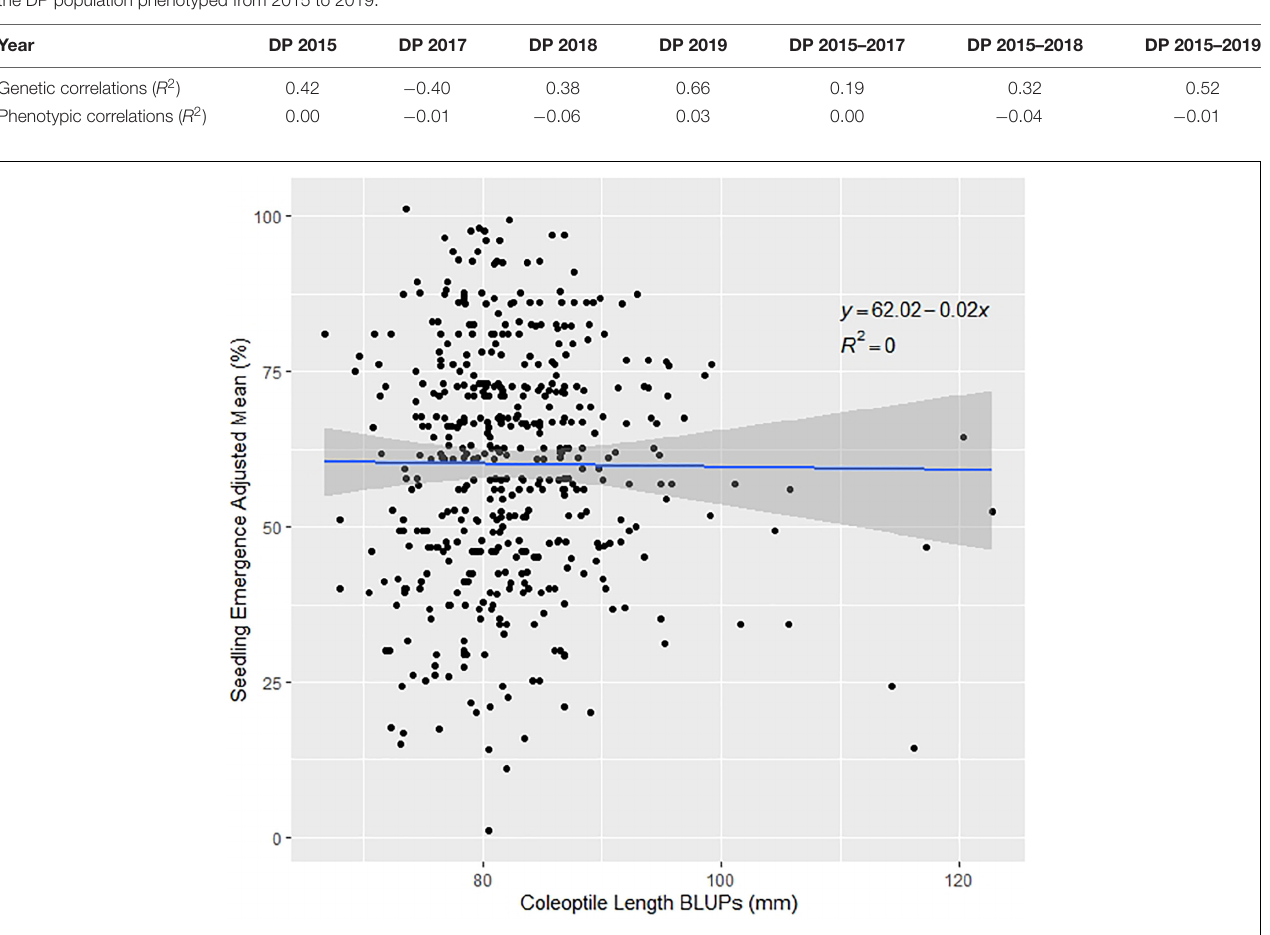
FIGURE 1 | Effect of coleoptile length on seedling emergence in the diversity panel varieties across the combined years of 2015–2019.